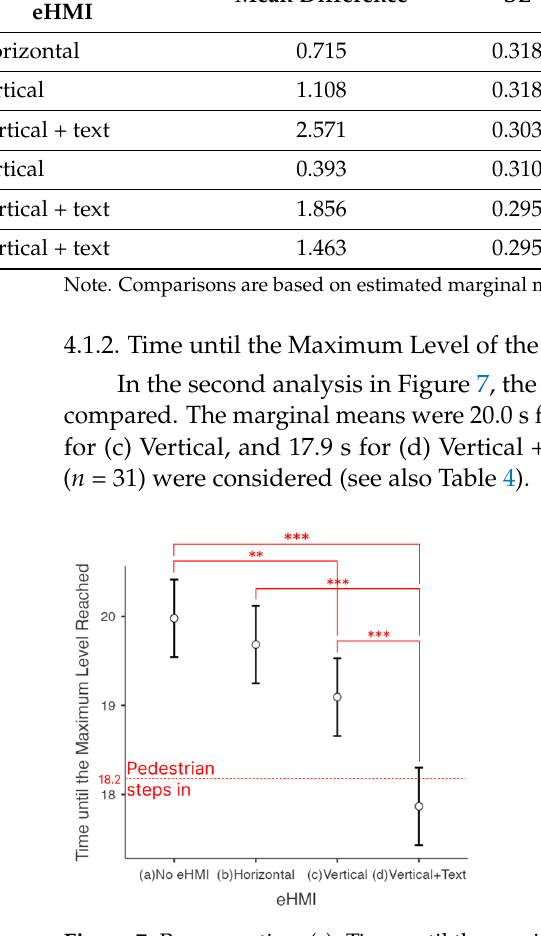
Figure 7. Response time (s): Time until the maximum level was reached. ** p < 0.01, *** p < 0.001. Table 4. Estimated marginal means of time until the maximum level of the willingness to stop was reached by tested cases (seconds).